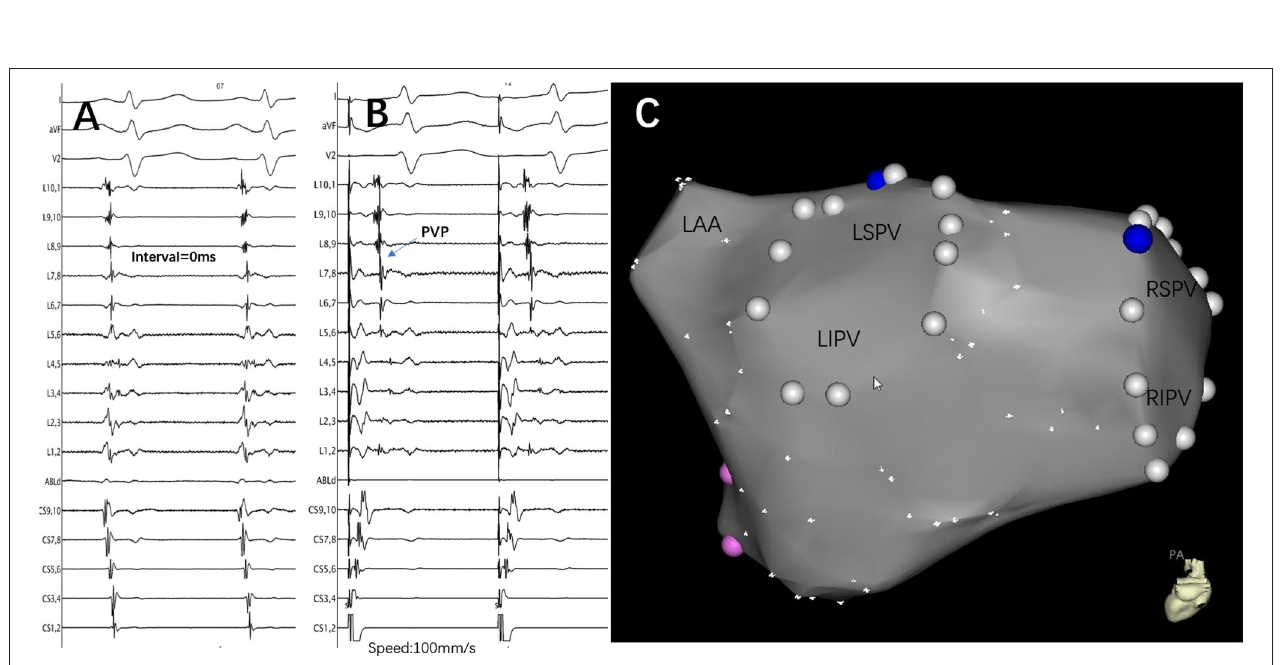
FIGURE 4 | An example of a conduction gap that was correctly predicted by the interval in a re-do patient. (A) Lasso was placed at the ostium of the LSPV, and the PV and left atrium were reconnected. The interval between FFP and PVP was 0ms. (B) Pacing at the distal CS catheter to distinguish and confirm the existence of PVP. (C) The successful ablation target was only located at the roof of the LSPV. The blue point represents the ablation target, the white point represents the pulmonary vein ostium, and the pink point represents the mitral valve. LSPV, left superior pulmonary vein; LIPV, left inferior pulmonary vein; RSPV, right superior pulmonary vein; RIPV, right inferior pulmonary vein; PV, pulmonary vein; LAA, left atrial appendage; CS, coronary sinus; FFP, far-field atrial potential; PVP, pulmonary vein potential; L1.2, Lasso catheter distal electrode; L9.10, Lasso catheter proximal electrode.